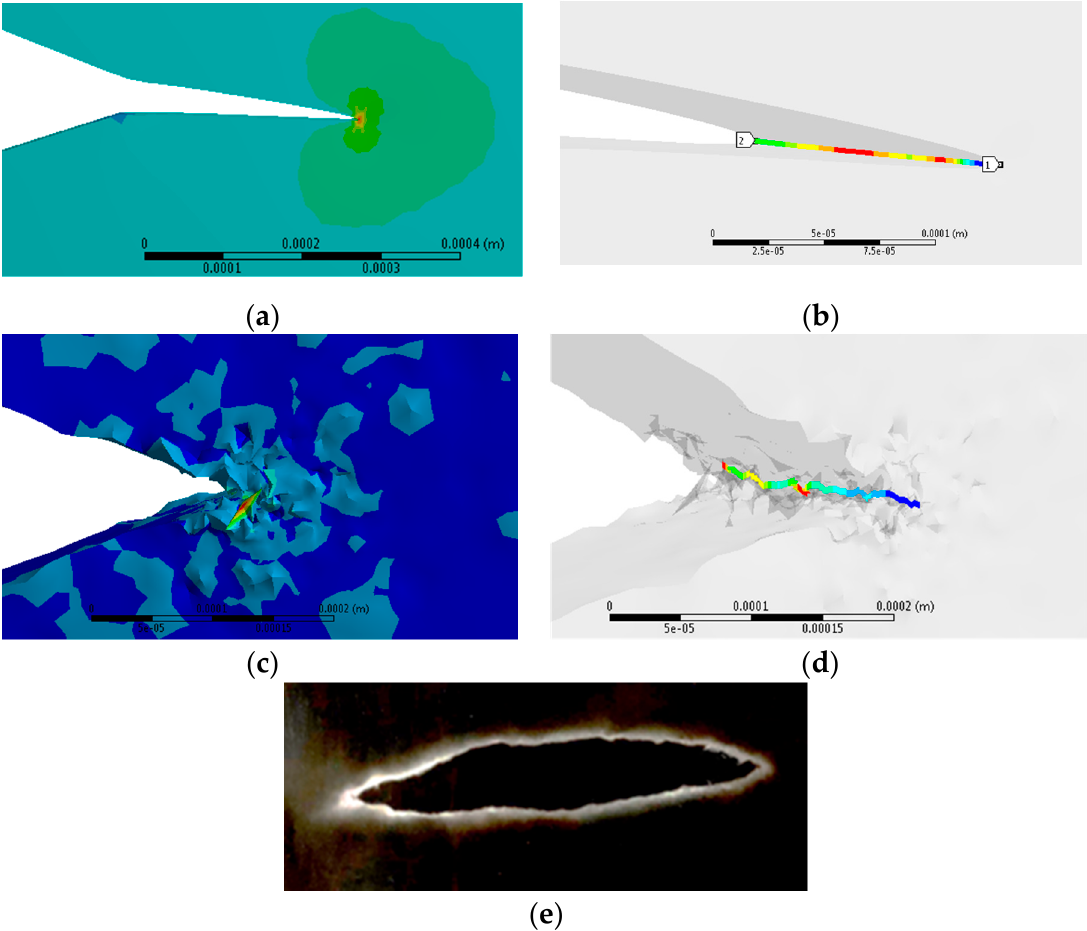
Figure 14. ( a ) Stress distribution around the tip of the crack in case 2a; ( b ) the horizontal line along the tip of the crack in case 2a; ( c ) Stress distribution around the tip of the crack in case 2b; ( d ) the erratic line along the tip of the crack created in case 2b and; ( e ) example of an evolved cavity observed in a HTVEM at × 50,000 in a molybdenum single